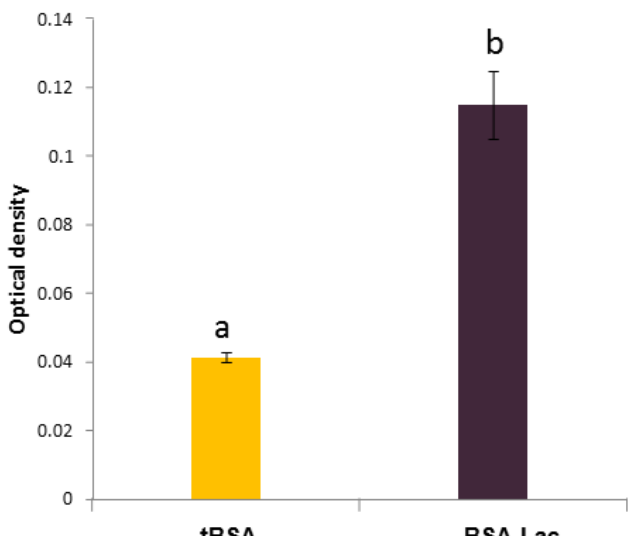
Figure 1. Enzyme-linked lectin recognition assays of lactosylated bovine serum albumin (BSA-Lac) and BSA thermally treated in the absence of lactose (tBSA). Optical density values were compared using the Student’s t-test. p ≤ 0.05. Different letters (a and b) indicate the statistical significance ( p ≤ 0.05).